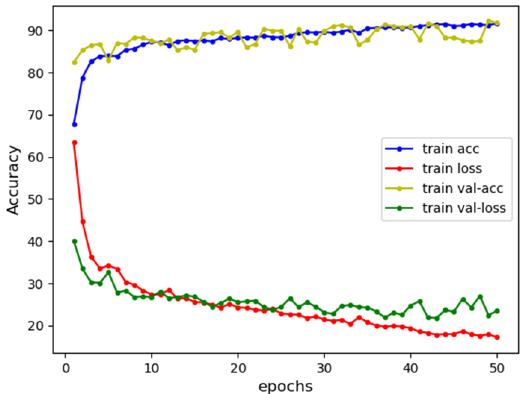
Figure 13. Plots of Acc-Loss during hybrid vulnerability detection.